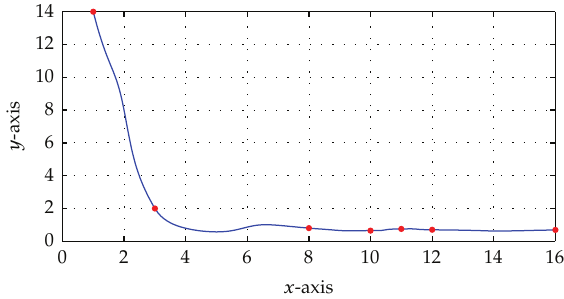
Figure 2: C 1 positive rational trigonometric cubic function with α i (cid:8) 0 . 5 , δ i (cid:8) 1 . 0.